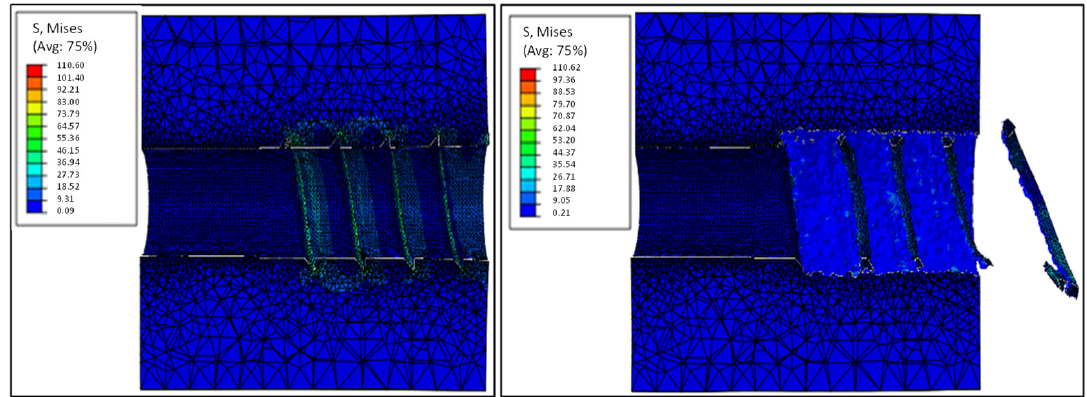
Figure 16. Stress distribution in the pull-out test substrate.